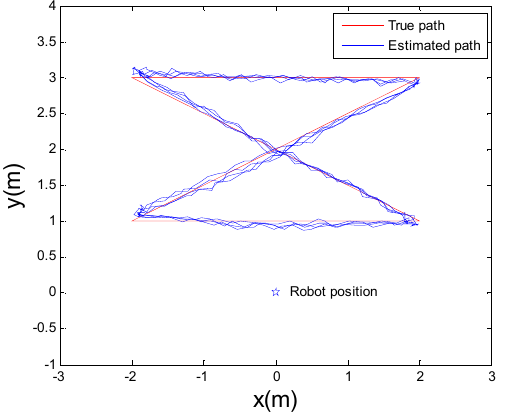
Figure 7. Comparison of ground truth and estimated track for 4× 2m with a crossed rectangular trajectory.